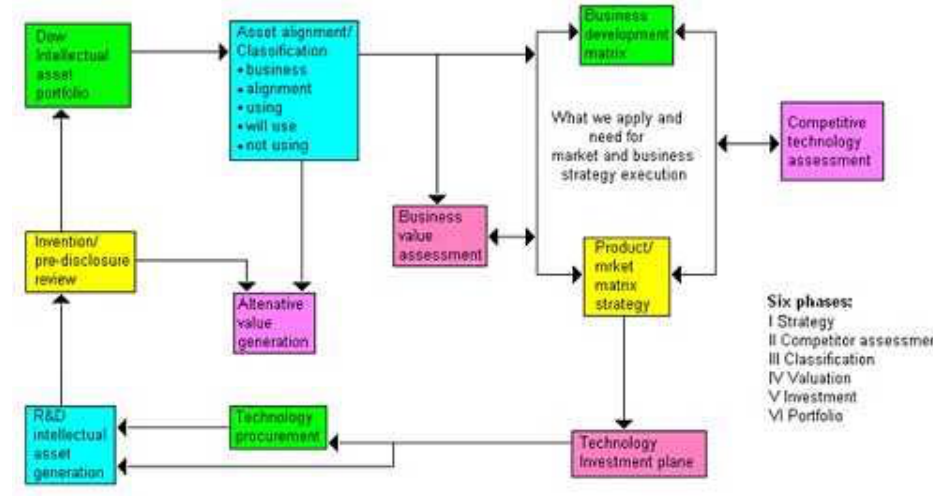
Figure 3 Dow's intellectual asset management model (Source: Skyrme and Amidon